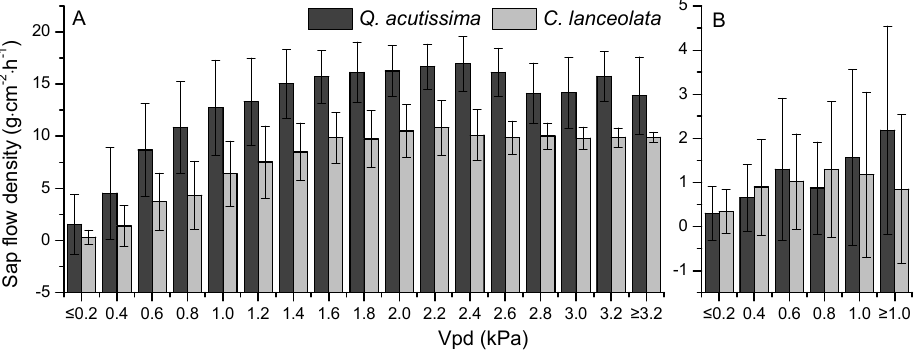
Figure 10. Values of sap flow density (( A ) daytime and ( B ) nighttime) for each V pd stage.